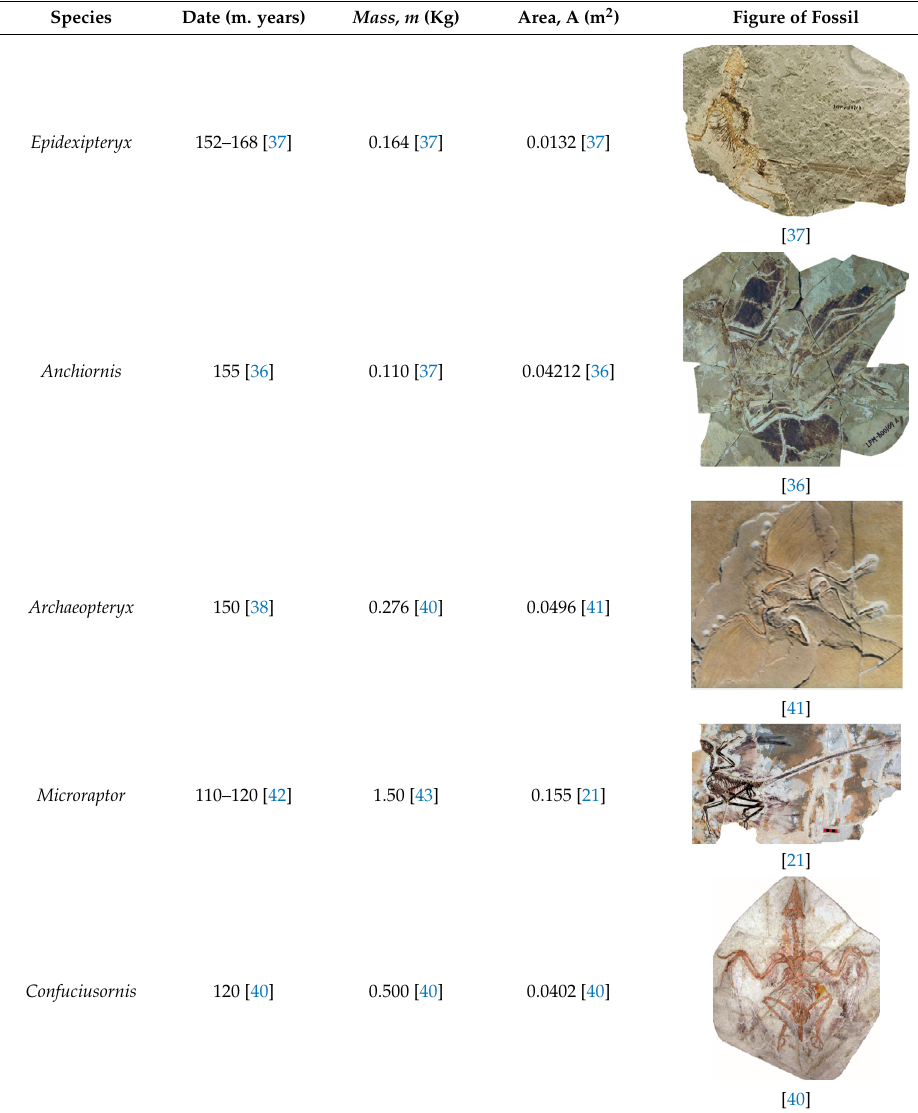
Figure 6. Trajectories of Anchiornis running at a speed of 8 m/s and θ = 0 ◦ : ( a ) v 2 changes from 0 to 12 m/s; ( b ) v 2 changes from 0 to 6 m/s; ( b ) v 2 changes from 8 to 12 m/s. Table 1. Living era, mass, effective area, and fossil pictures of Epidexipteryx , Anchiornis , Archaeopteryx , Microraptor , and Confuciusornis .